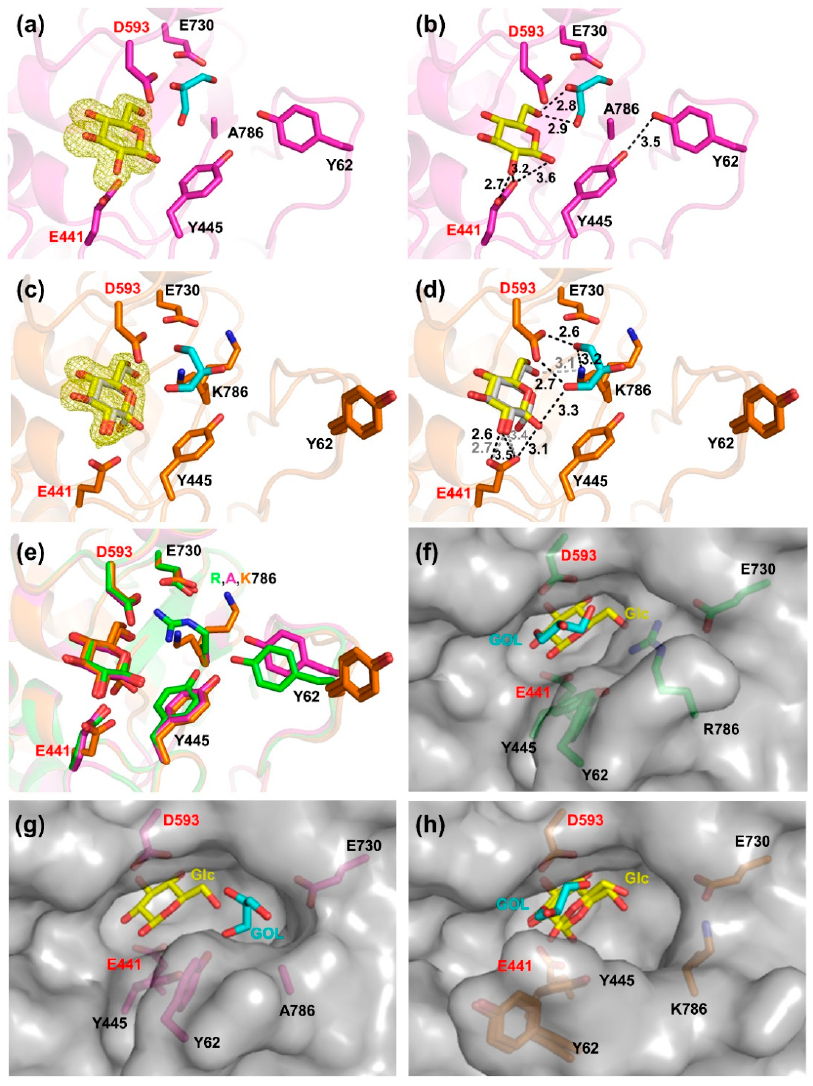
Figure 5. Active site comparison between Tx GH116 R786A and R786K and the wild type (WT) with glucose ligand. The glucose ligand weighted |F O -F C | electron density maps calculated with the ligands omitted and contoured at 3 σ are shown in the active sites of the glucose complexes of R786A ( a ) and R786K ( c ). Active site interactions with glucose and glycerol molecules are shown for R786A ( b ) and R786K ( d ), in which, with two anomers, glucose ligands were found (alpha 80%, in grey and beta 20%, in yellow). ( e ) Superposition of active site residues of WT (PDB: 5BX5, green [17]), R786A (magenta), and R786K (orange). Slot-like active site entrance comparison between WT ( f ), R786A ( g ) and R786K ( h ). R786A and R786K have an enlarged entrance space, with an extra glycerol molecule in the place of the original arginine side chain. The potential hydrogen bonds between the glucose (Glc) ligands (yellow sticks) and surrounding residues are displayed as black dashed lines. Glycerol (GOL) molecules are shown as cyan sticks, and catalytic residues are labeled in